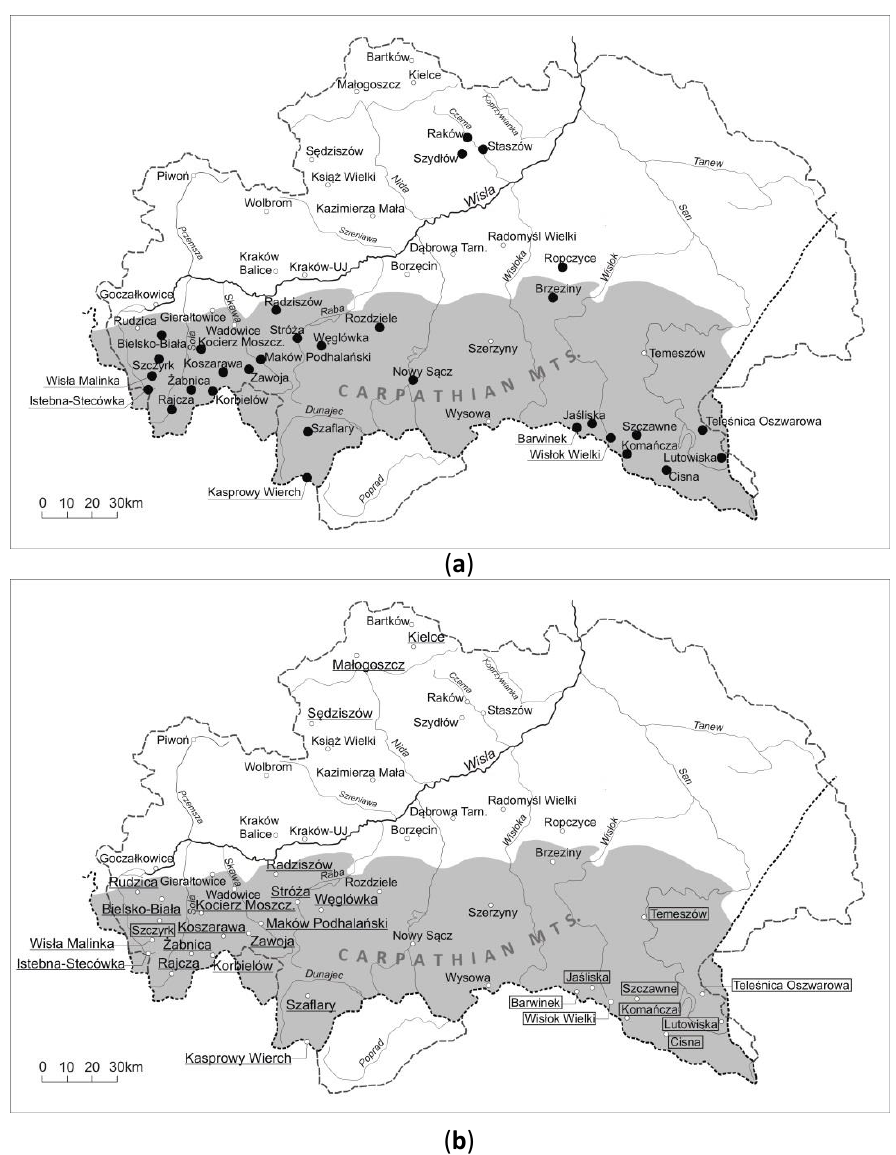
Figure 5. Location of the weather stations with the annual maximum daily precipitation on 15 May 2014 ( a ); and 6 and 7 September 1996 ( b